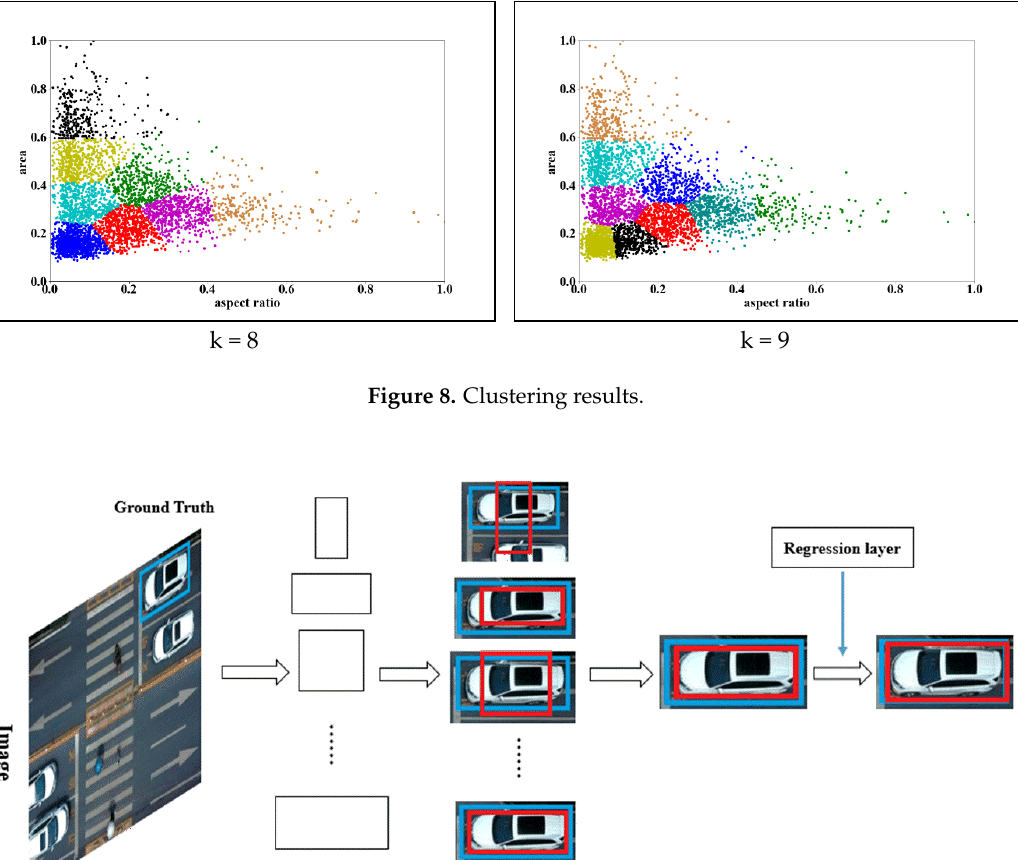
Table 1. Centroid table after area aspect ratio clustering.